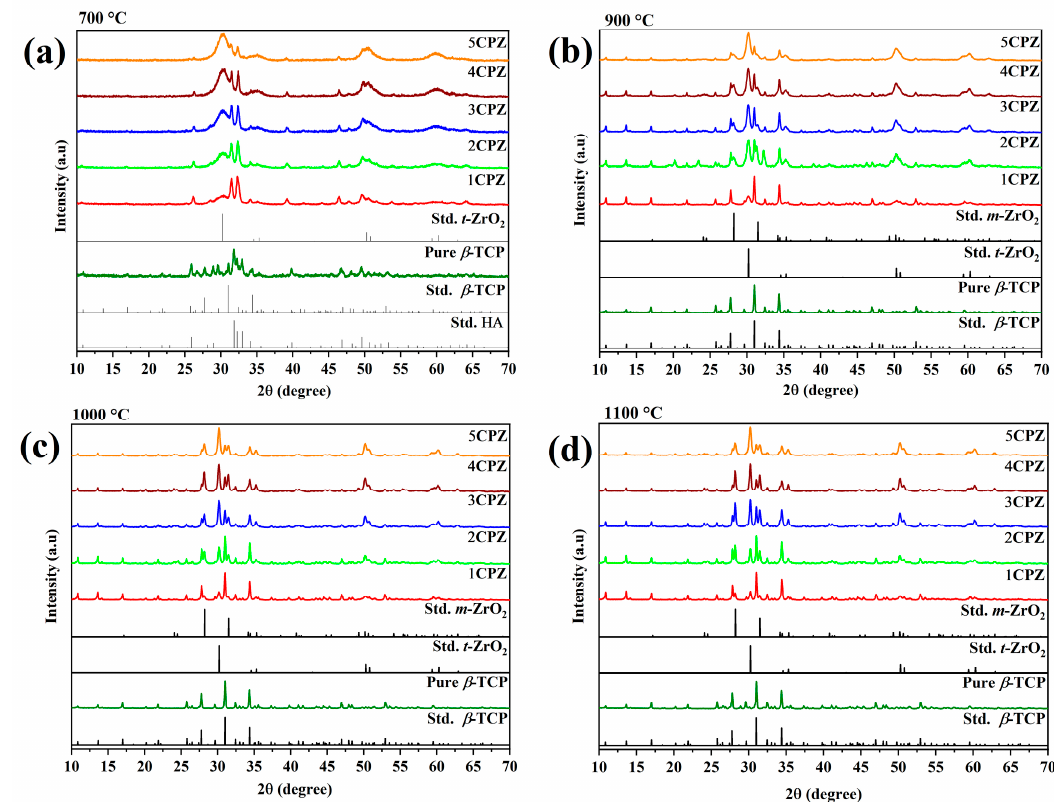
Figure 2. The figures represent the X-ray diffraction of β -Ca 3 (PO 4 ) 2 –ZrO 2 composites heat-treated at ( a ) 700 °C , ( b ) 900 °C , ( c ) 1000 °C , and ( d ) 1100 °C , respectively. The diffraction standard for HA- Ca 10 (PO 4 ) 6 (OH) 2 , β - Ca 3 (PO 4 ) 2 , t -ZrO2, and m -ZrO2 is represented by ICDD Card Nos: 00–009–0432,